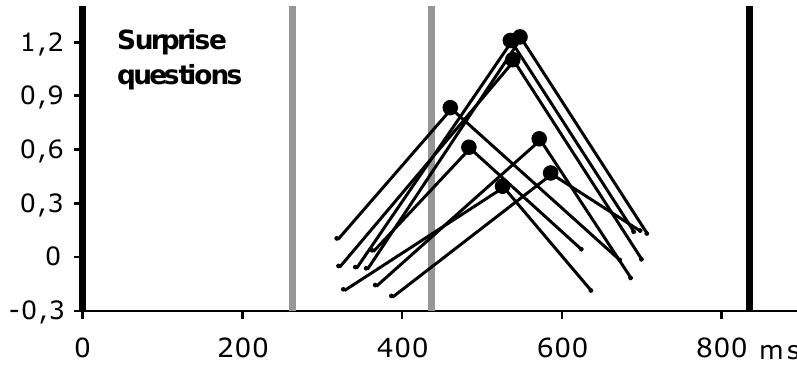
Figure 2. Plots of the tokens that were recognized particularly well in the perception experiments, for the categories A, C, D, and E. The vertical black bars represent the extent of the final verb. The vertical grey bars delimit the stressed syllable in the verb. The plots are normalized for F0 and for time (see explanation in the text) and pool the relevant productions of all six